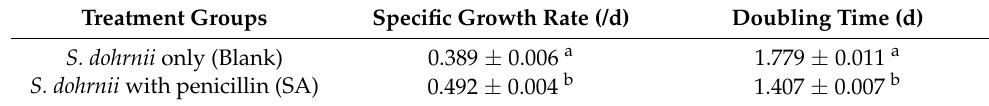
value represents mean ± SD ( n = 3).